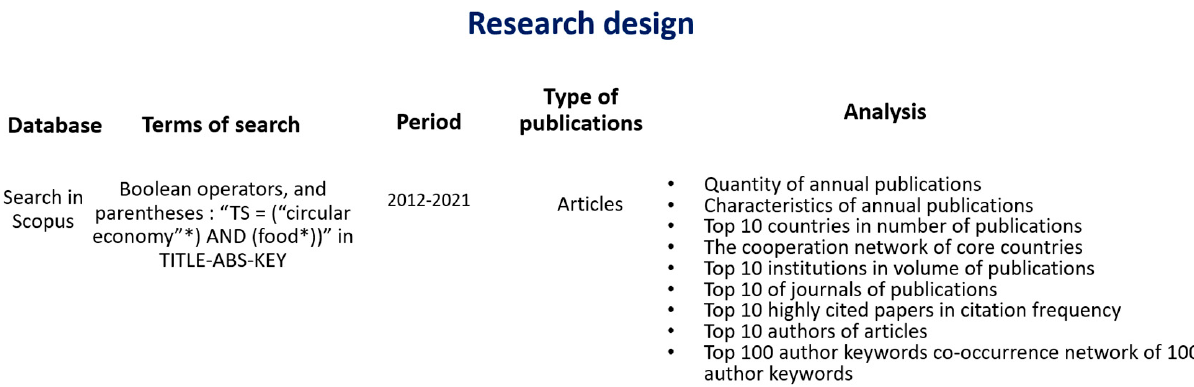
Figure 1. The research design of the study. Source: Authors’ elaboration.